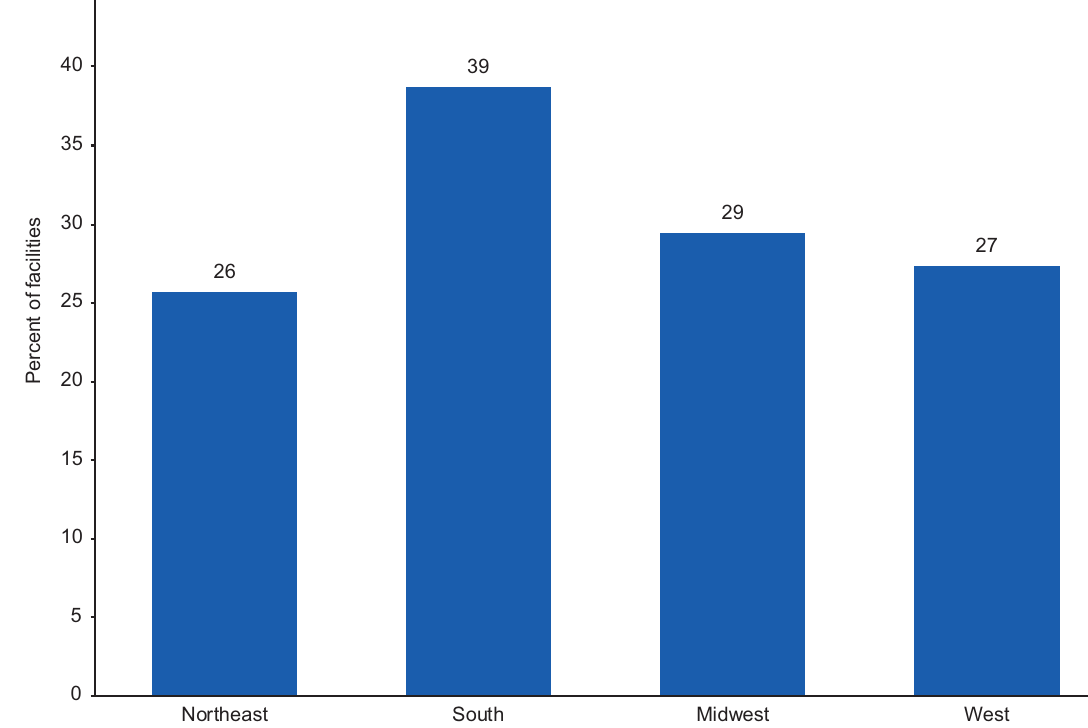
Figure 10. Mental health treatment facilities offering psychiatric emergency walk-in services, by region: